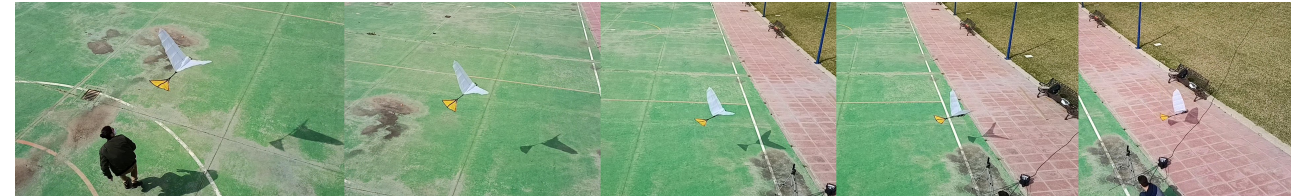
Figure 17. Twist Flapping-Flight Composition Test. Top